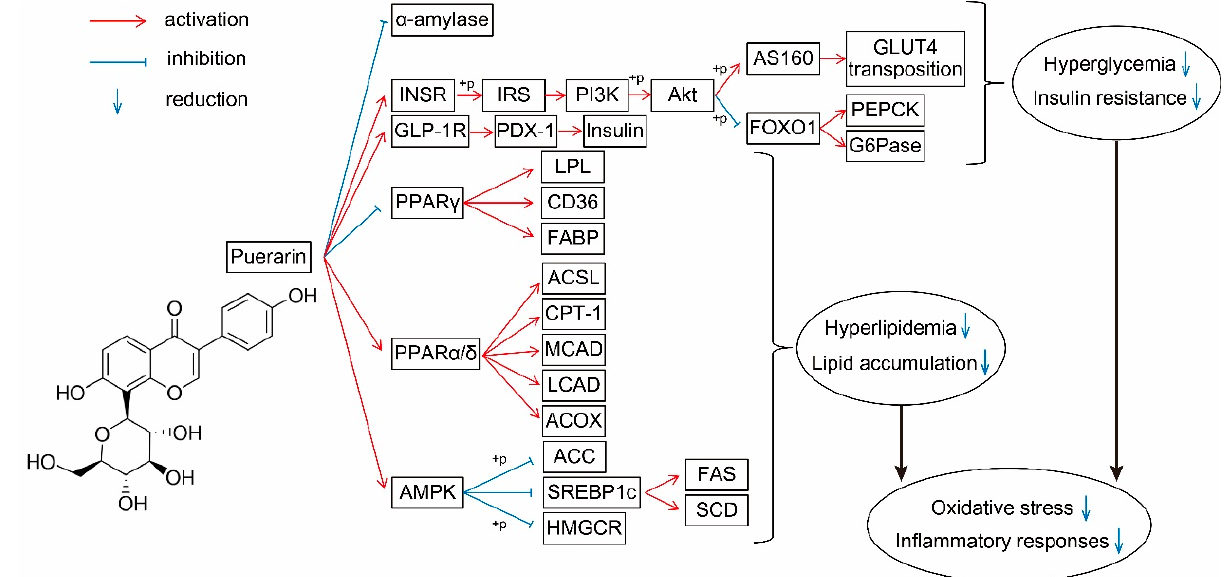
Figure 2. Effect of puerarin on sugar and lipid metabolism and its molecular mechanisms. Red lines, activation; blue lines, inhibition; down arrows, reduction. INSR, insulin receptor; IRS, insulin recep-